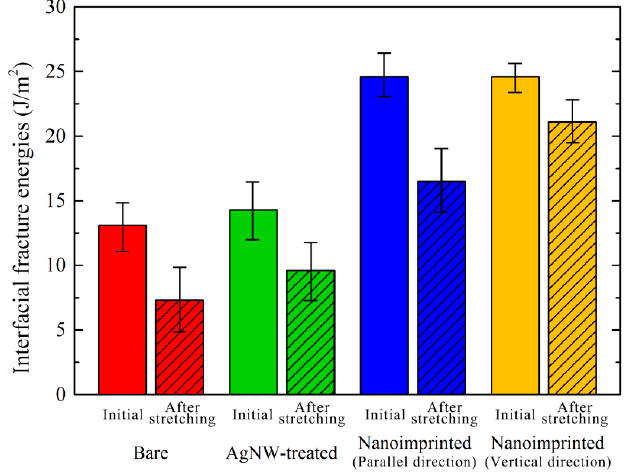
Figure 5. Measured interfacial fracture energies of Ag thin film on the bare PDMS, AgNW-treated PDMS and nanoimprinted PDMS substrates.